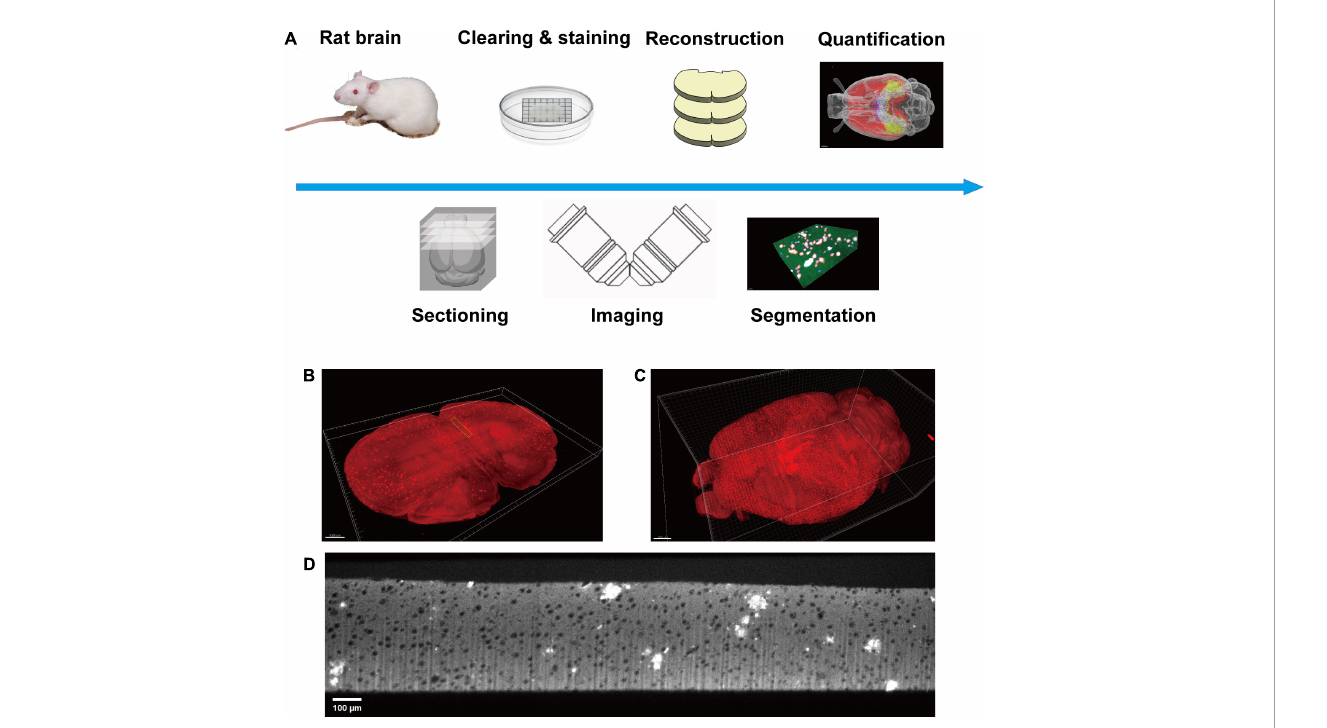
FIGURE1 Diagram of this study. (A) The pipeline of the whole process, including sample preparation, data acquisition, plaque segmentation, and quantification analysis. (B) Single slice imaged with micron resolution. (C) The 3D-reconstructed whole rat brain. (D) The raw image of a section in panel (B) , green